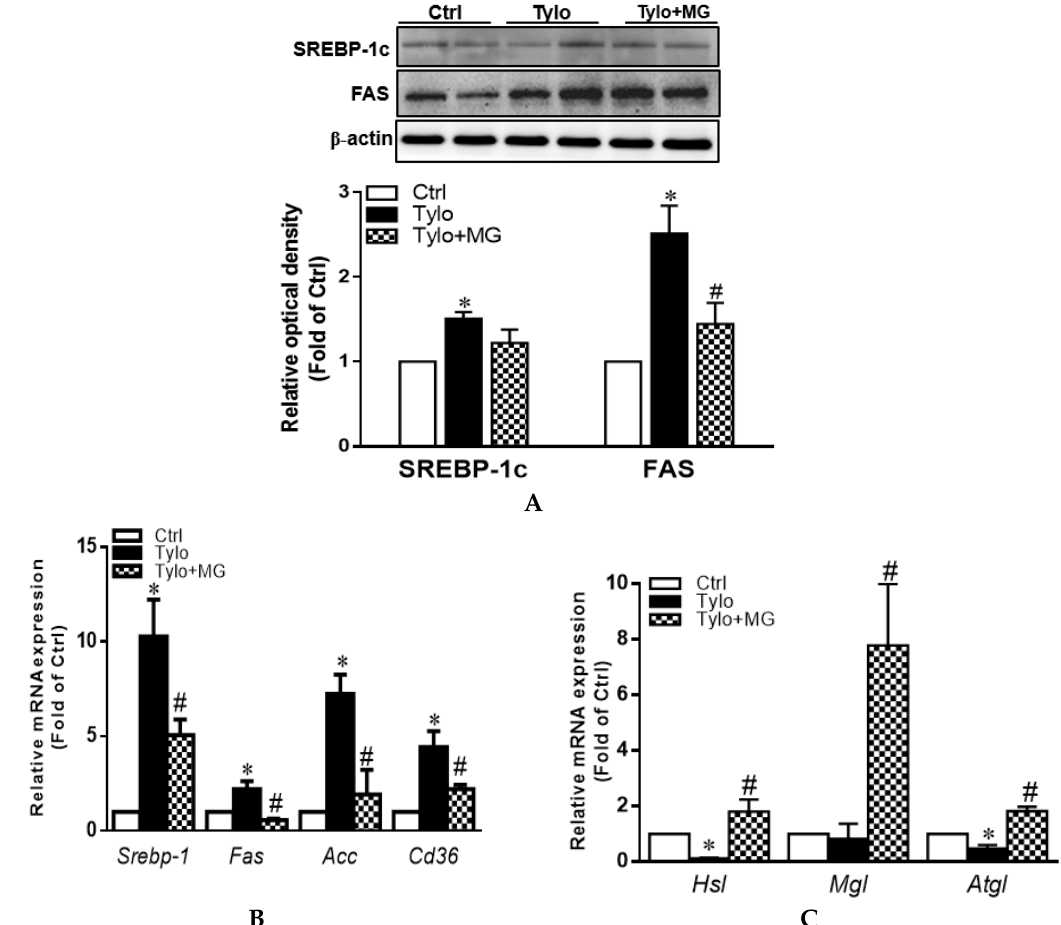
Figure 2. Effects of magnolol (MG) treatment on lipid homeostasis in the liver of tyloxapol-injected rats. ( A ) Representative Western blot and densitometry analysis of sterol regulatory element-binding protein-1c (SREBP-1c) and fatty acid synthase (FAS); ( B ) mRNA expression of Srebp1 , Fas , Acc , and Cd36 ; ( C ) mRNA expression of Hsl , Mgl , and Atgl . Data are expressed as mean ± SEM, n = 5–12. * p < 0.05 vs. Ctrl; # p < 0.05 vs. Tylo (tyloxapol).